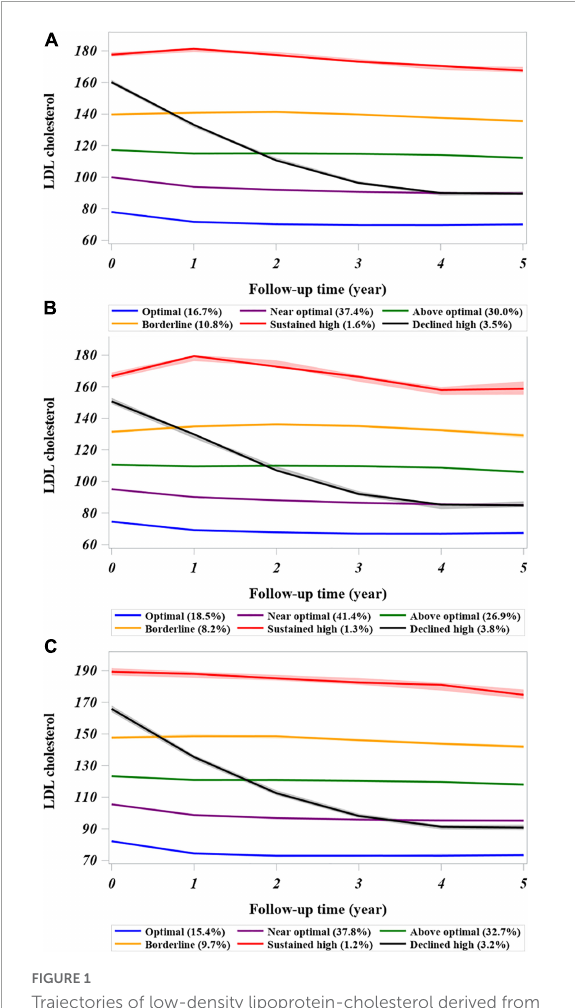
FIGURE1 Trajectories of low-density lipoprotein-cholesterol derived from the latent class growth mixed model in the cohort of patients with CKD. (A) Entire chronic kidney disease cohort. (B) Patients with CKD and diabetes at baseline. (C) Patients with CKD without diabetes at baseline. The LDL-C trajectory classes were defined as follows: 1, sustained high; (baseline LDL-C > 160 mg/dL that continued over time); 2, declined high (baseline LDL-C ≥ 160 mg/dL but declined to < 100 mg/dL in the follow-up period); 3, borderline high baseline LDL-C remained in range of 130–159 mg/dL over time; 4, above optimal (baseline LDL-C around 120 mg/dL); 5, near-optimal (baseline LDL-C around 100 mg/dL); and 6, optimal (baseline LDL-C level < 100 mg/dL). The LDL-C values represent the group mean with the confidence interval (shadowed). CKD, chronic kidney disease.